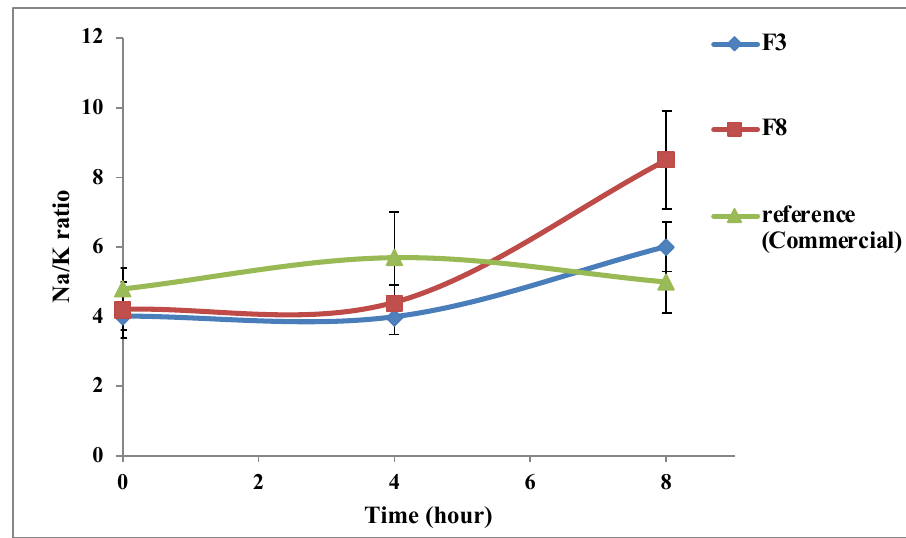
FIGURE 8 - Na + /K + ratios after oral administration of commercial and tested Eplerenone tablets. *F3: contains 50 % PEO WSR in the coating layer, F8: contains 22 % Carbopol 71 G in the coating layer.